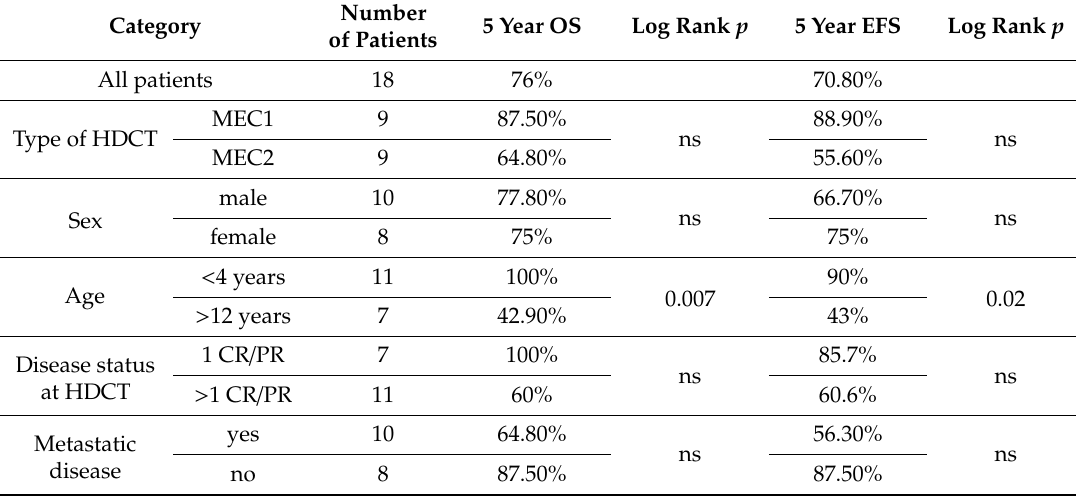
Table 3. Survival analysis